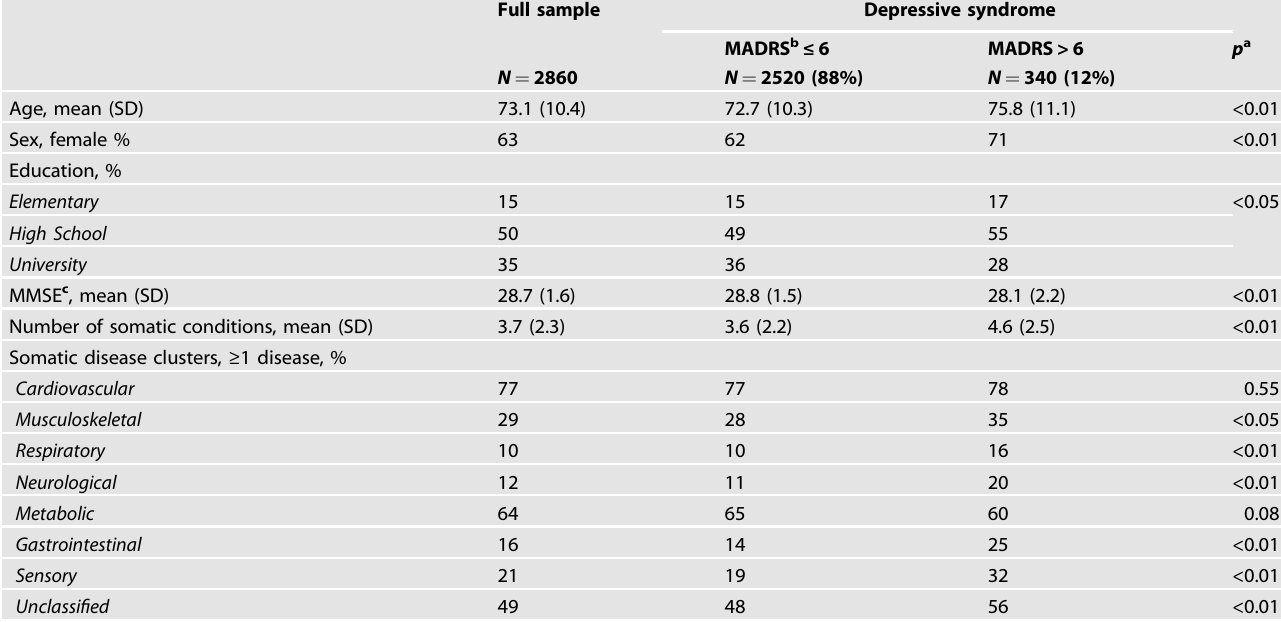
Table 1. Descriptive characteristics of the overall study population and according to the presence of burdensome depressive